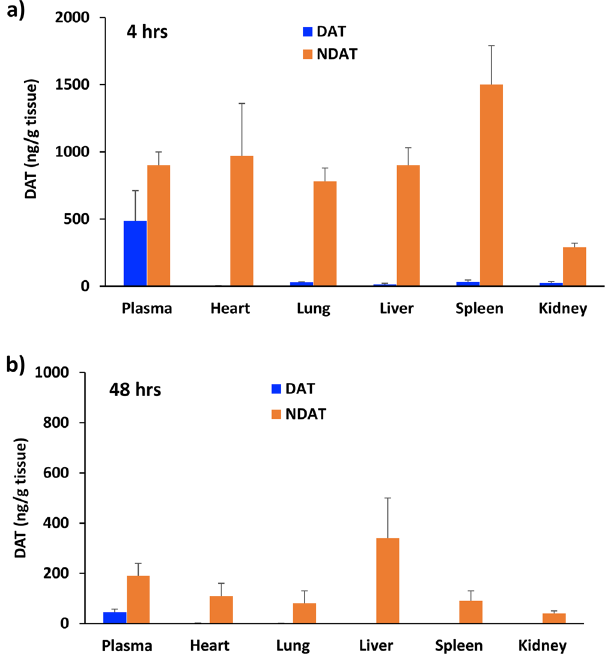
Figure 8. Biodistribution of DAT administered subcutaneously into mice at equivalent DAT amount of 3 mg/ kg body weight ( a ) as NDAT nanoformulation, and ( b ) as DAT/Cremophor EL micelles formulation. Shown are DAT amounts in plasma and major organs (heart, lung, liver, spleen, and kidney) determined at 4 and 48 hours. Data are shown as mean ± SD (n = 4), and all data have significance (P < 0.001) for NDAT compared to DAT.